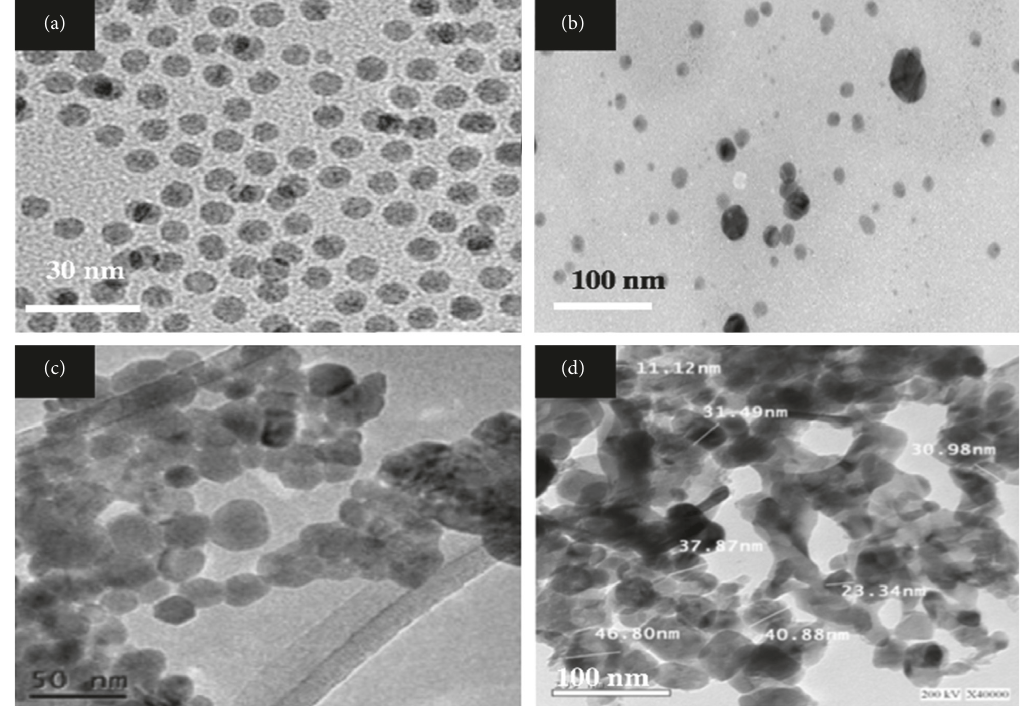
Figure 4: TEM images of several metals. (a) Ag NPs [25], (b) Au NPs [42], (c) ZnO NPs [67], and (d) CuO NPs